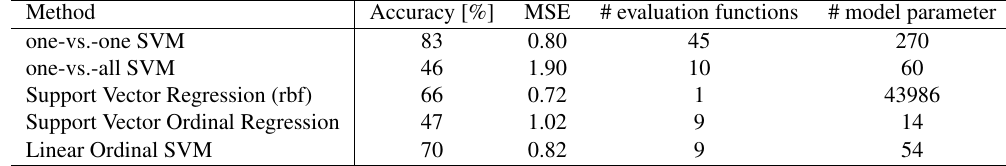
Table 3: Performance overview on the barley data set